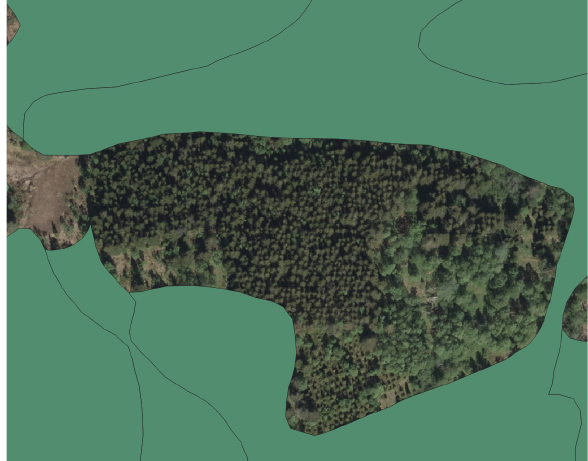
Figure 4. The open forest seen in this figure is an example of forest areas absent in the land resource map but included in the new forest cover